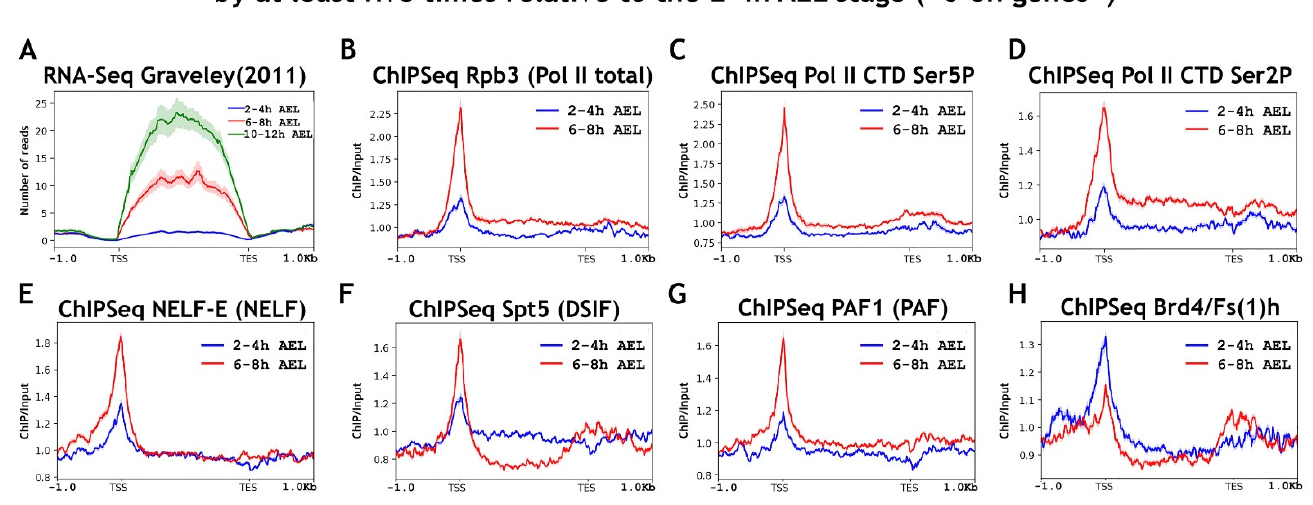
Figure 2. Average binding profiles of various RNA polymerase II isoforms and elongation regulators NELF, DSIF, PAF, and Brd4/Fs(1)h on genes induced at the 6–8 h AEL (after egg laying) stage of Drosophila embryogenesis. Average distribution of ( A ) RNA-seq signal and ChIP-Seq signal of ( B ) Rpb3 (Pol II subunit), ( C ) Pol II Ser5P CTD, ( D ) Pol II Ser2P CTD, ( E ) NELF-E, ( F ) Spt5, ( G ) PAF1, and ( H ) Brd4/Fs(1)h across the genes induced at the 6–8 h stage of Drosophila embryogenesis by at least five times relative to the 2–4 h AEL stage (total number genes in “6–8 h genes” set are 420 (corresponded to 1253 transcripts)). ChIP-Seqs were performed on whole embryos of 2–4 h (blue line) and 6–8 h (red line) after eggs laying (AEL). A pool of “6–8 h AEL genes” was selected using previously published data [51]. Protein binding levels were calculated as an enrichment (ratio of the corresponding ChIP-Seq signal to the input DNA). Average profiles were generated using the metagene mode (introns were ignored and gene bodies were scaled to 2 kb) and calculated as the median of the protein binding signal. Average profiles of the RNA-seq signal were calculated as the mean level. The standard error appears on the graphs as a lighter area around the main line of the profiles. Abbreviations: TSS: transcription start site; TES: transcription end